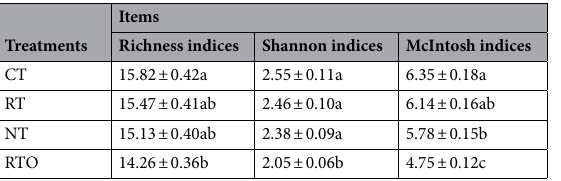
Table 4. Effects of different tillage treatments on diversity of soil microbial community in a double-cropping rice field.